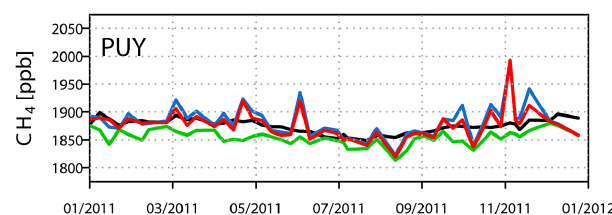
Figure 7. Comparison of the prior (blue), posterior (red) and back- ground (green) simulated CH 4 mixing ratios (ppb) with observa- tions (black) at the independent site, PUY. Results are shown for test